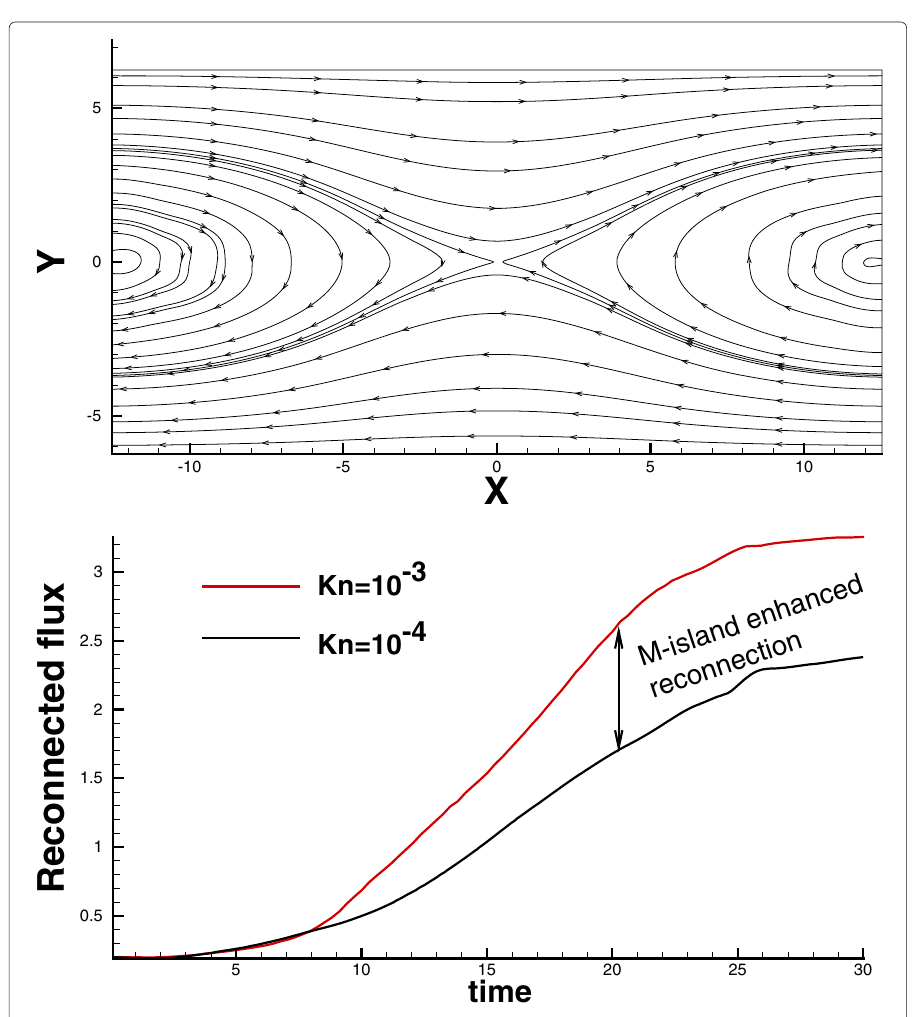
30 in continuum regime with Kn=10 4 .